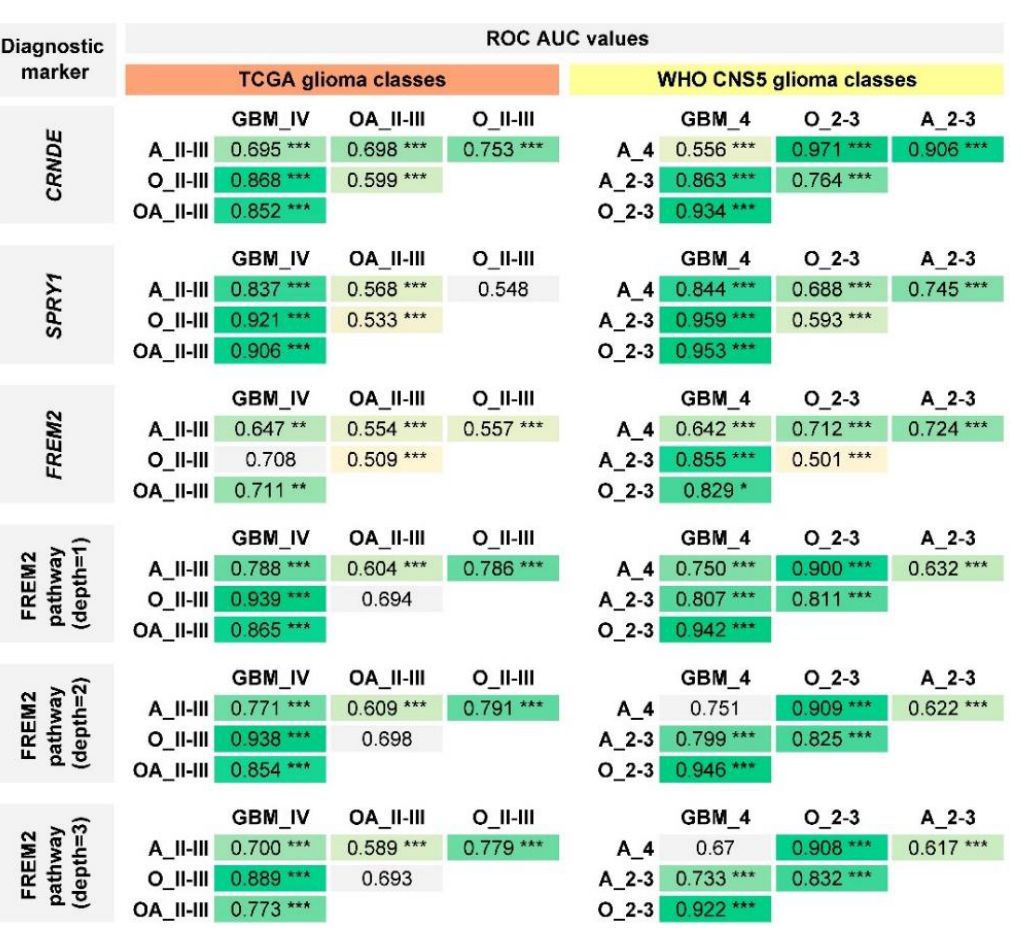
Figure 10. Performance of CRNDE , SPRY1 , and FREM2 expression and FREM2 pathway activation levels for discrimination of glioma types. GBM_IV — glioblastoma, grade IV (n = 169); OA_II-III—oligoastrocytoma, grade II–III (n = 115); O_II-III—oligodendroglioma, grade II–III (n = 181); A_II-III—astrocytoma, grade II–III (n = 169); GBM_4—glioblastoma, IDH -wildtype, grade